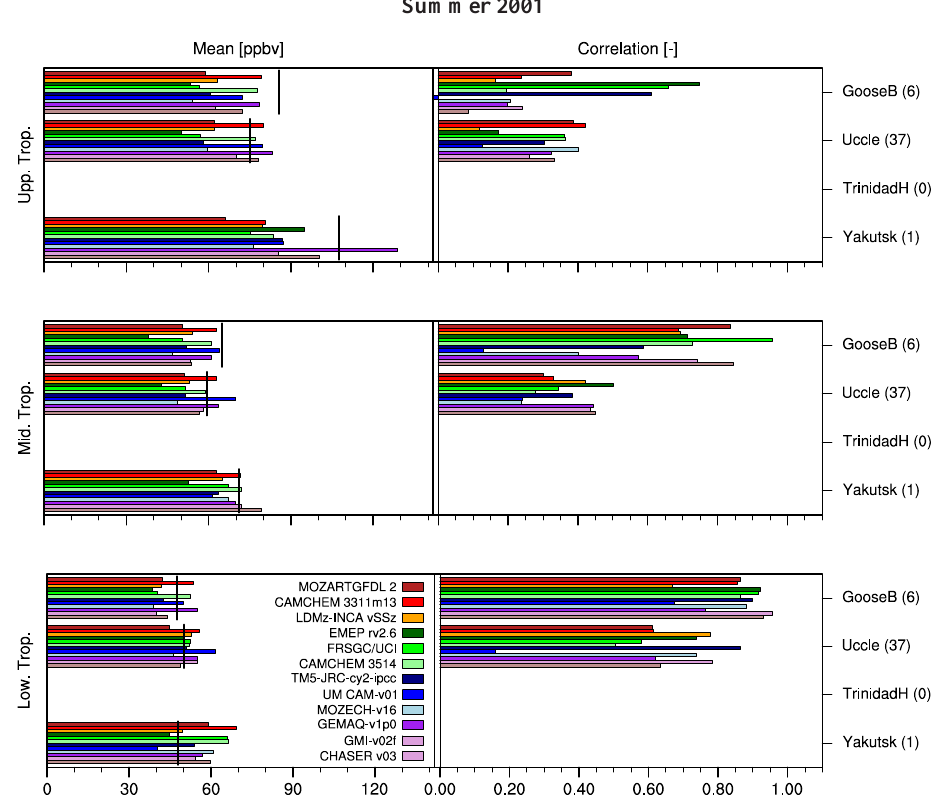
Fig. 5: Measured and model-calculated ozone (ppb) in summer (June, July, August) for the lower troposphere (900 - 700hPa), middle troposphere (700 - 500hPa) and upper troposphere (500 - 300hPa) for the selected ozonesonde sites. Concentrations to the left (solid lines crossing the model calculations are measurements), correlations to the right. The numbers behind the site name refer to the number of soundings available for comparison in Summer. GooseB. is short for Goose Bay, TrinidadH is short for Trinidad Head.